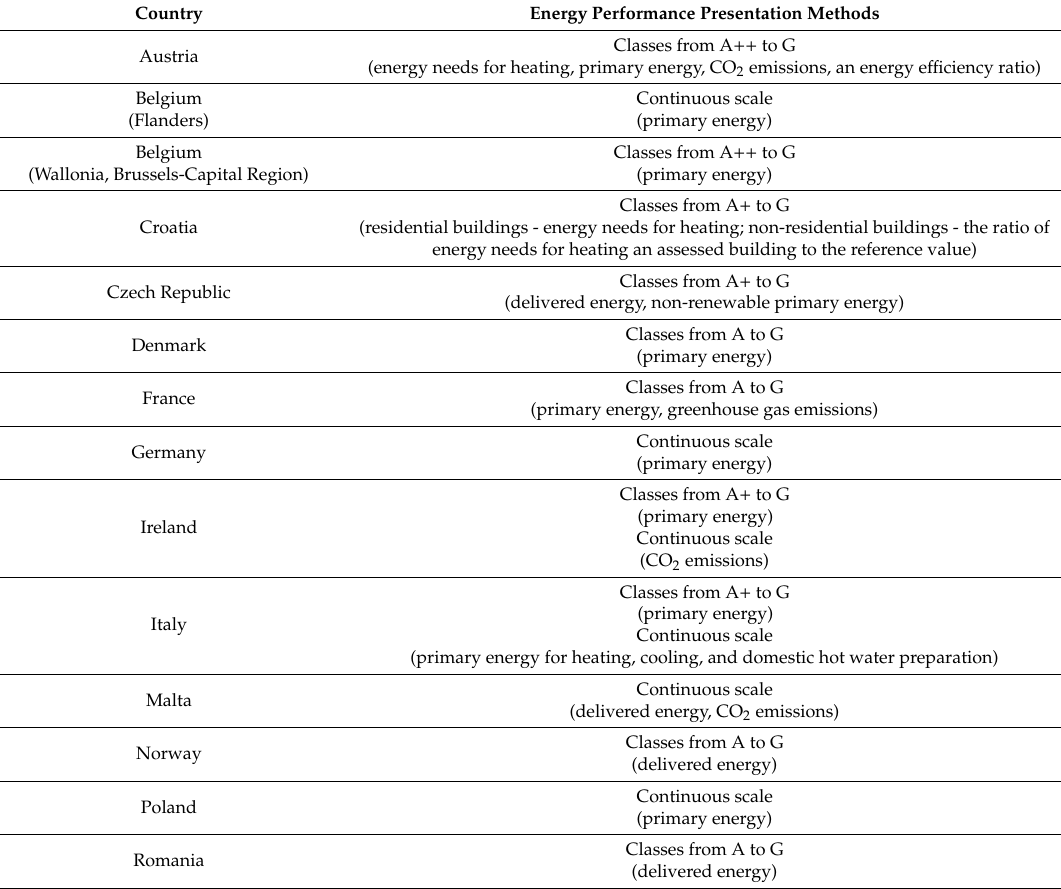
Table 1. Methods for presenting energy performance characteristics in selected EU countries